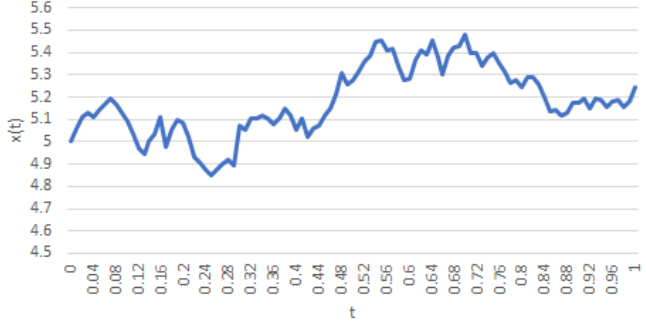
Figure 1. A realization of a trajectory of (7) with x 0 = 5, η = 1, σ ≡ 0.5, u ( t ) = and N = 100.